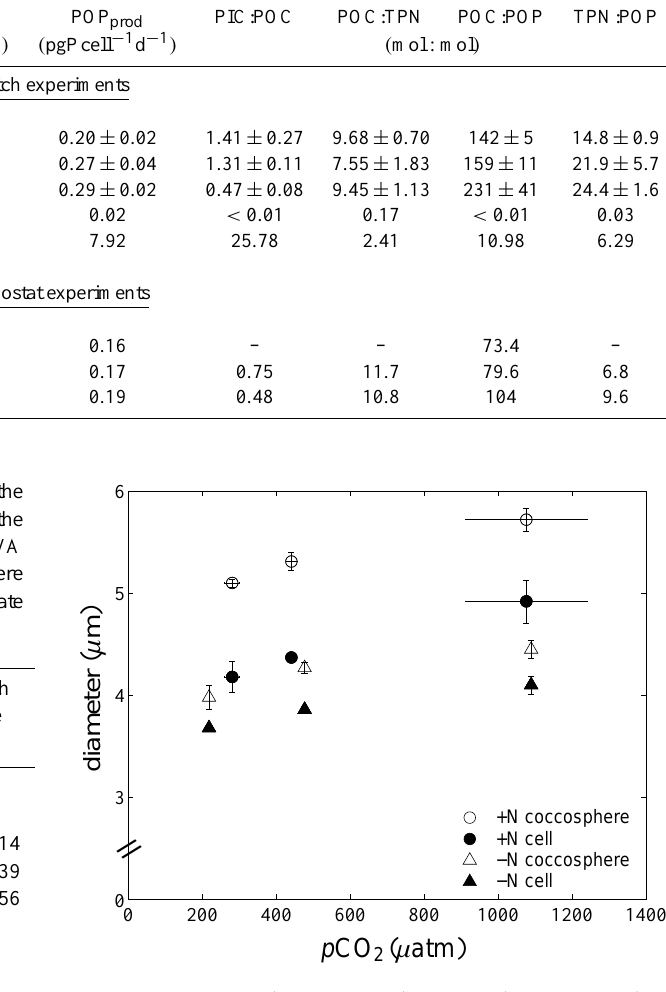
Fig. 2. Coccosphere (open symbols) and cell (filled symbols) diameter under nutrient replete (+N, circles) and nitrogen limitation (-N, triangles) in regard to p CO 2 levels.